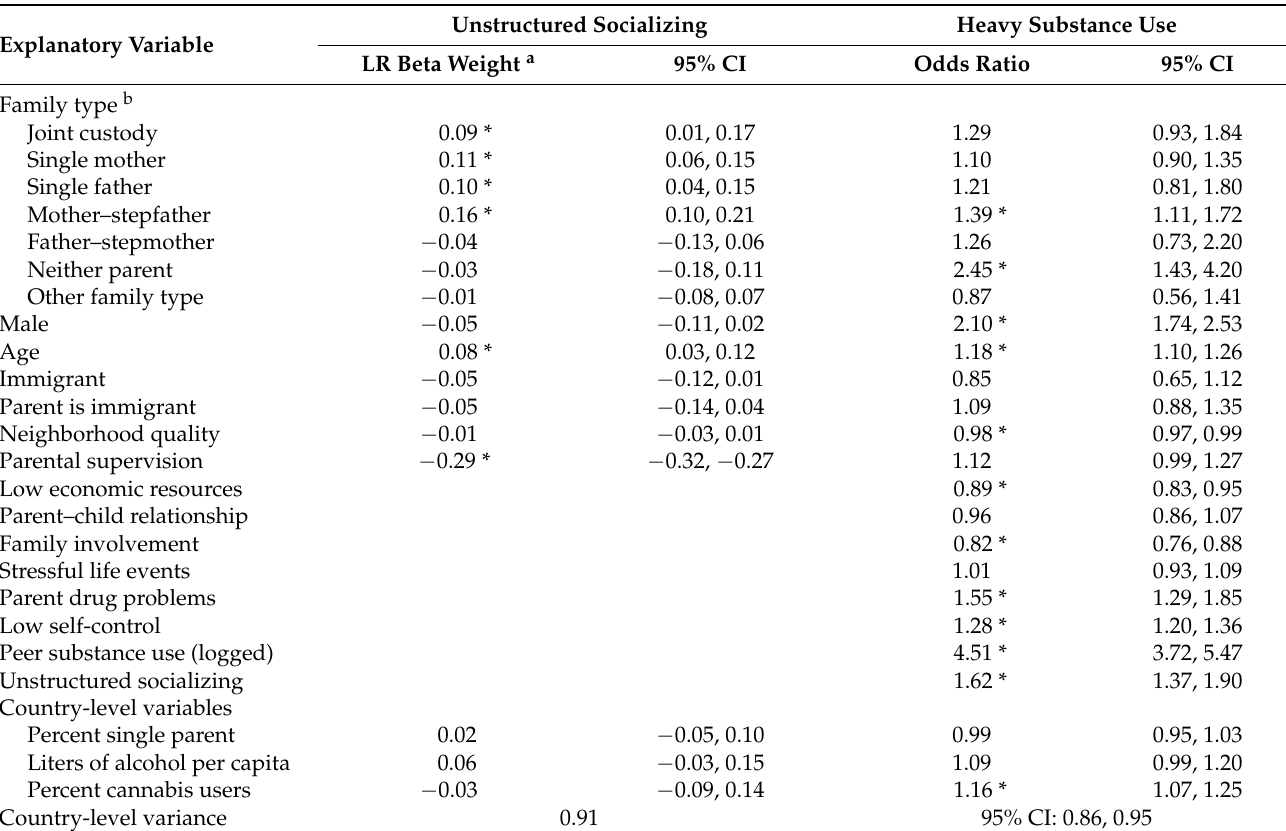
Table 5. Multilevel SEM of unstructured socializing and heavy substance use among adolescents, ISRD-2,